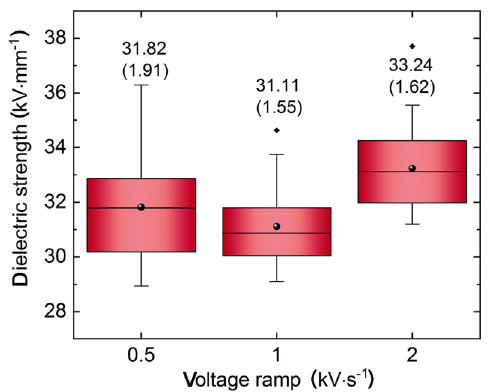
Fig. 3 Dielectric strength (AC) of 380 µm thick Al 2 O 3 tested with different voltage ramp rates. Arithmetic mean values are drawn as black dot and written in the diagram, standard deviation in parentheses. Boxes show the median, 5%, and 95% percentiles, and whiskers show minimum and maximum values. Outliers are drawn as black diamonds.